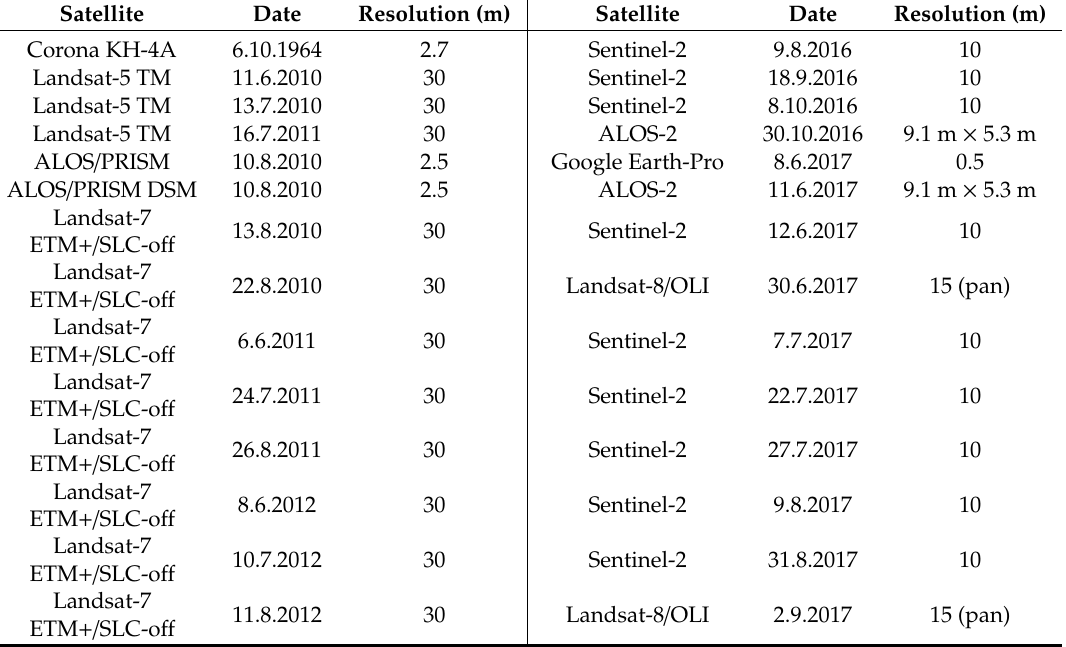
Table 1. List of satellite images used for the